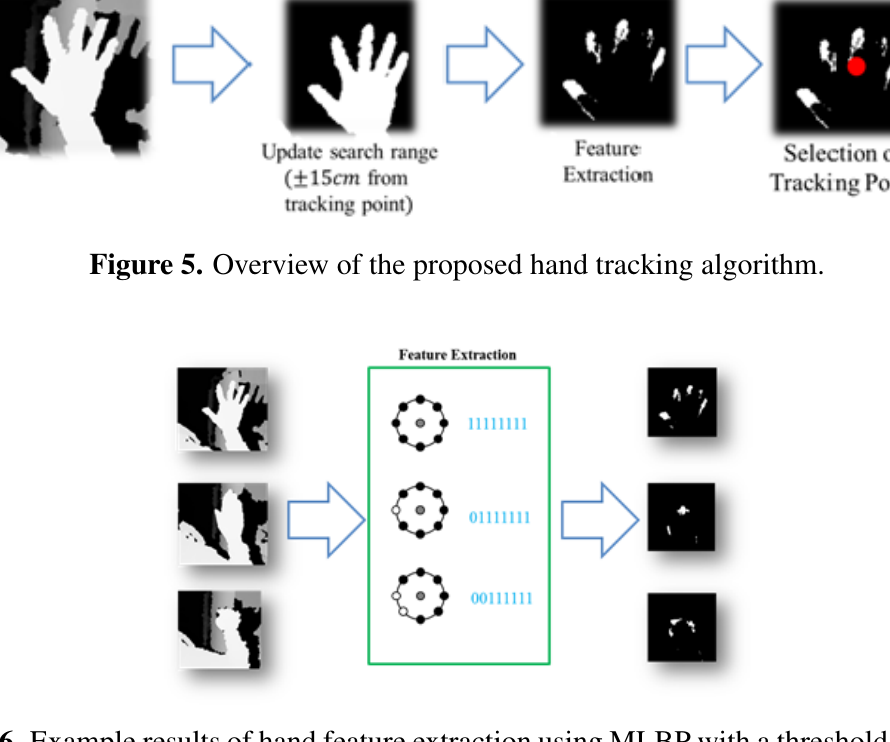
Figure 6. Example results of hand feature extraction using MLBP with a threshold of 10